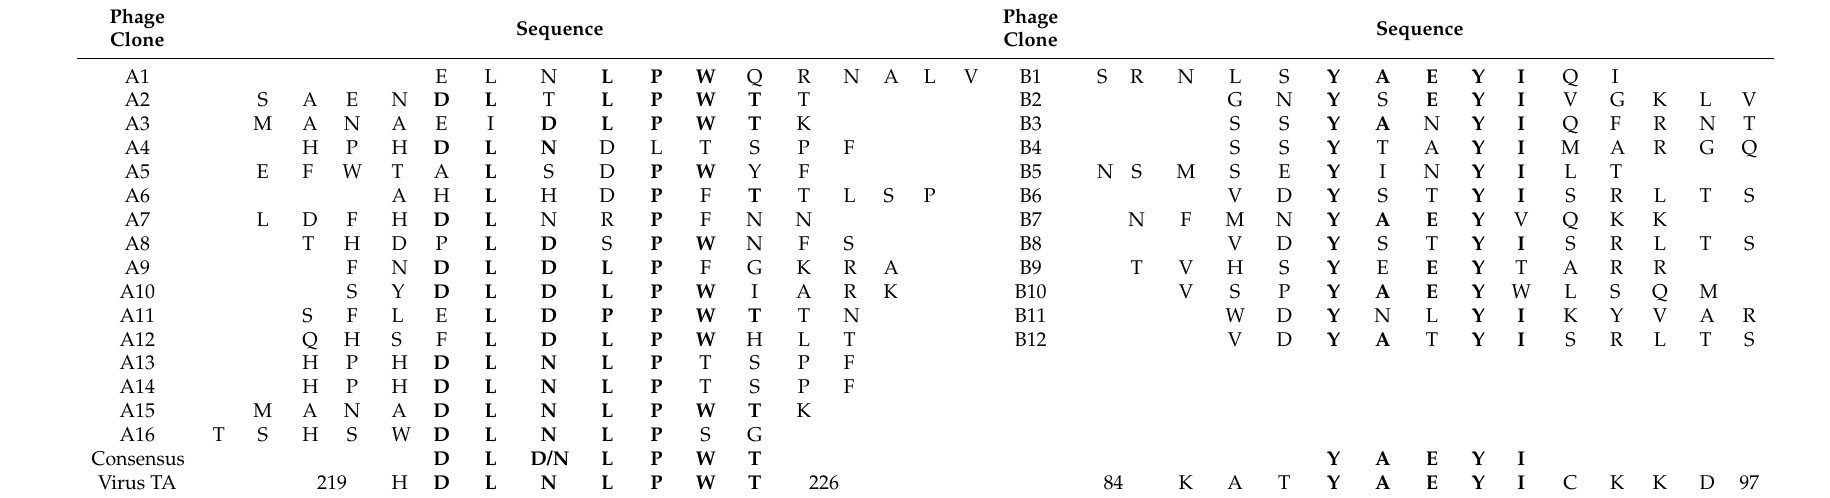
Table 1. Peptide sequences of the selected phage